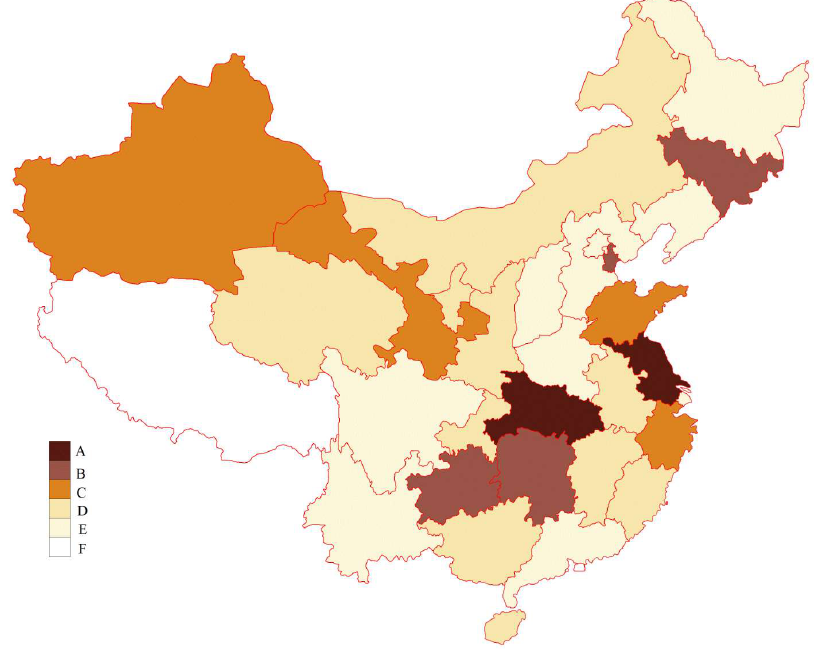
Figure 1. Geographic homogeneity and heterogeneity for 30 provinces.